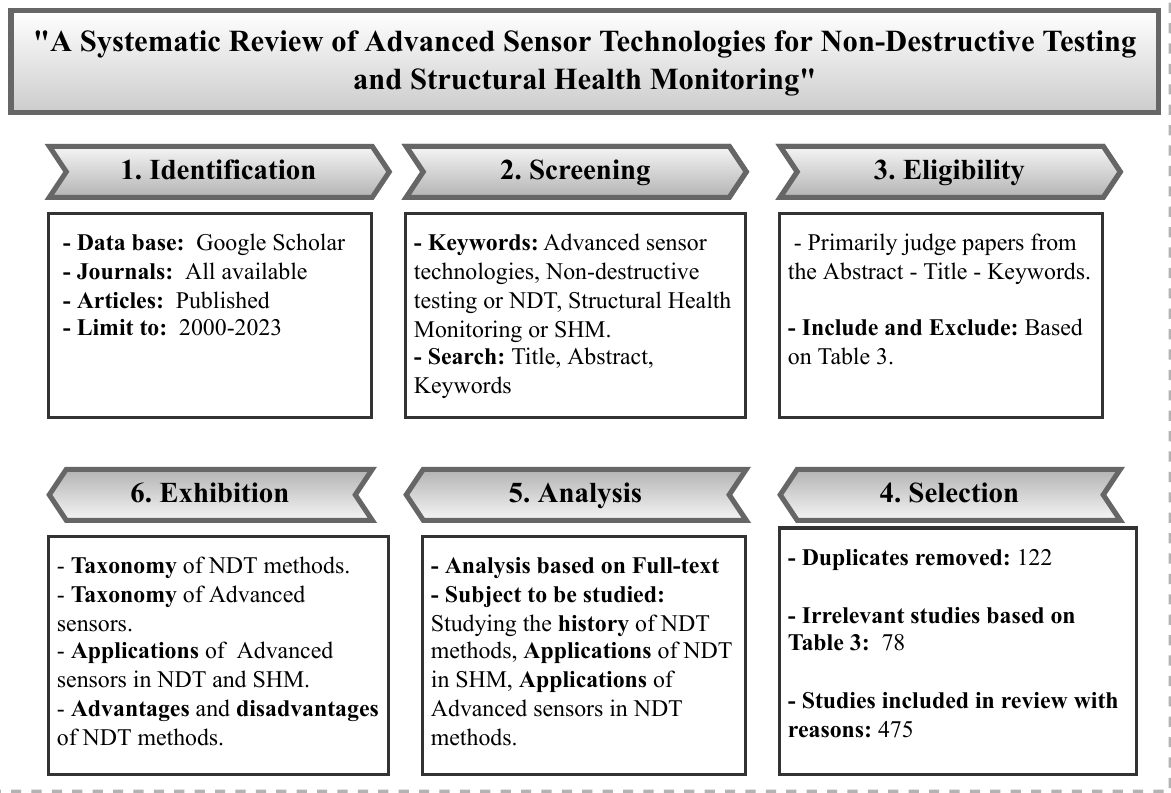
Figure 1. Process for selecting, researching, and analyzing relevant research